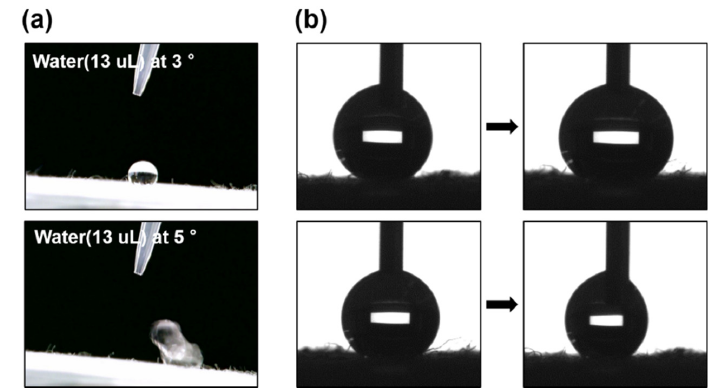
Figure 6. The captured images of ( a ) shedding angles for water and ( b ) the advancing angle measurement ( top ) and the receding angle measurement ( bottom ) for contact angle hysteresis.